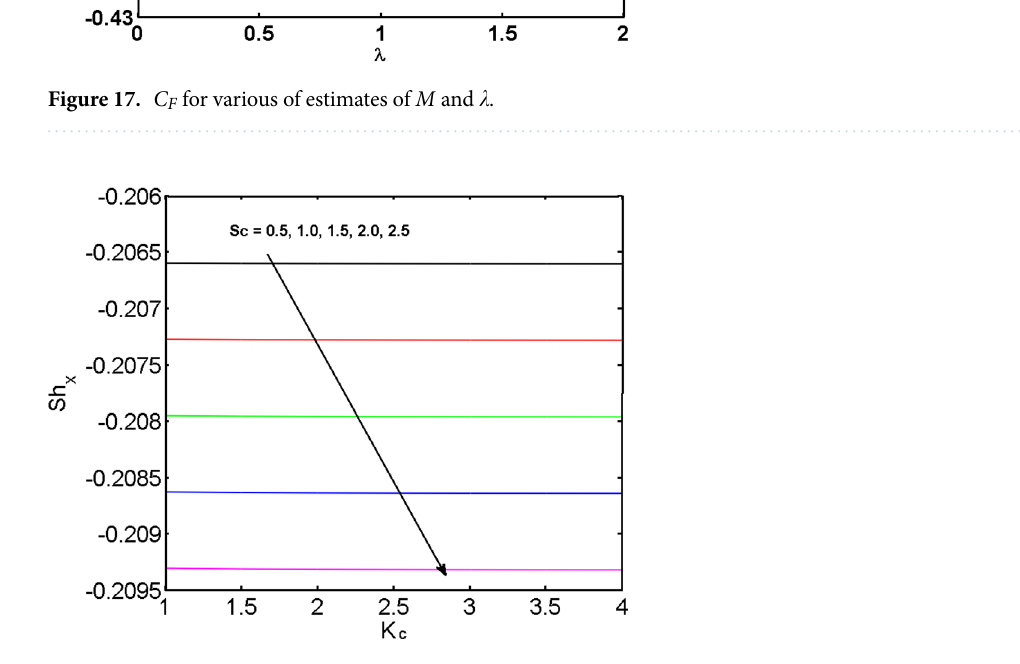
Figure 18. Sh x for various estimates of K c and Sc